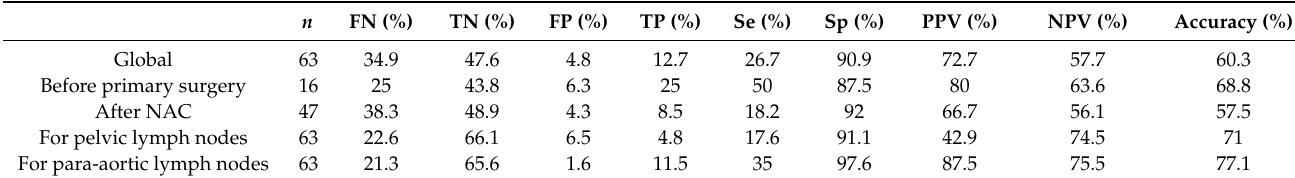
Table 3. Performance of positron emission tomography/computed tomography (PET-CT) for lymph node assessment in advanced Epithelial ovarian, fallopian tubal, or peritoneal cancer